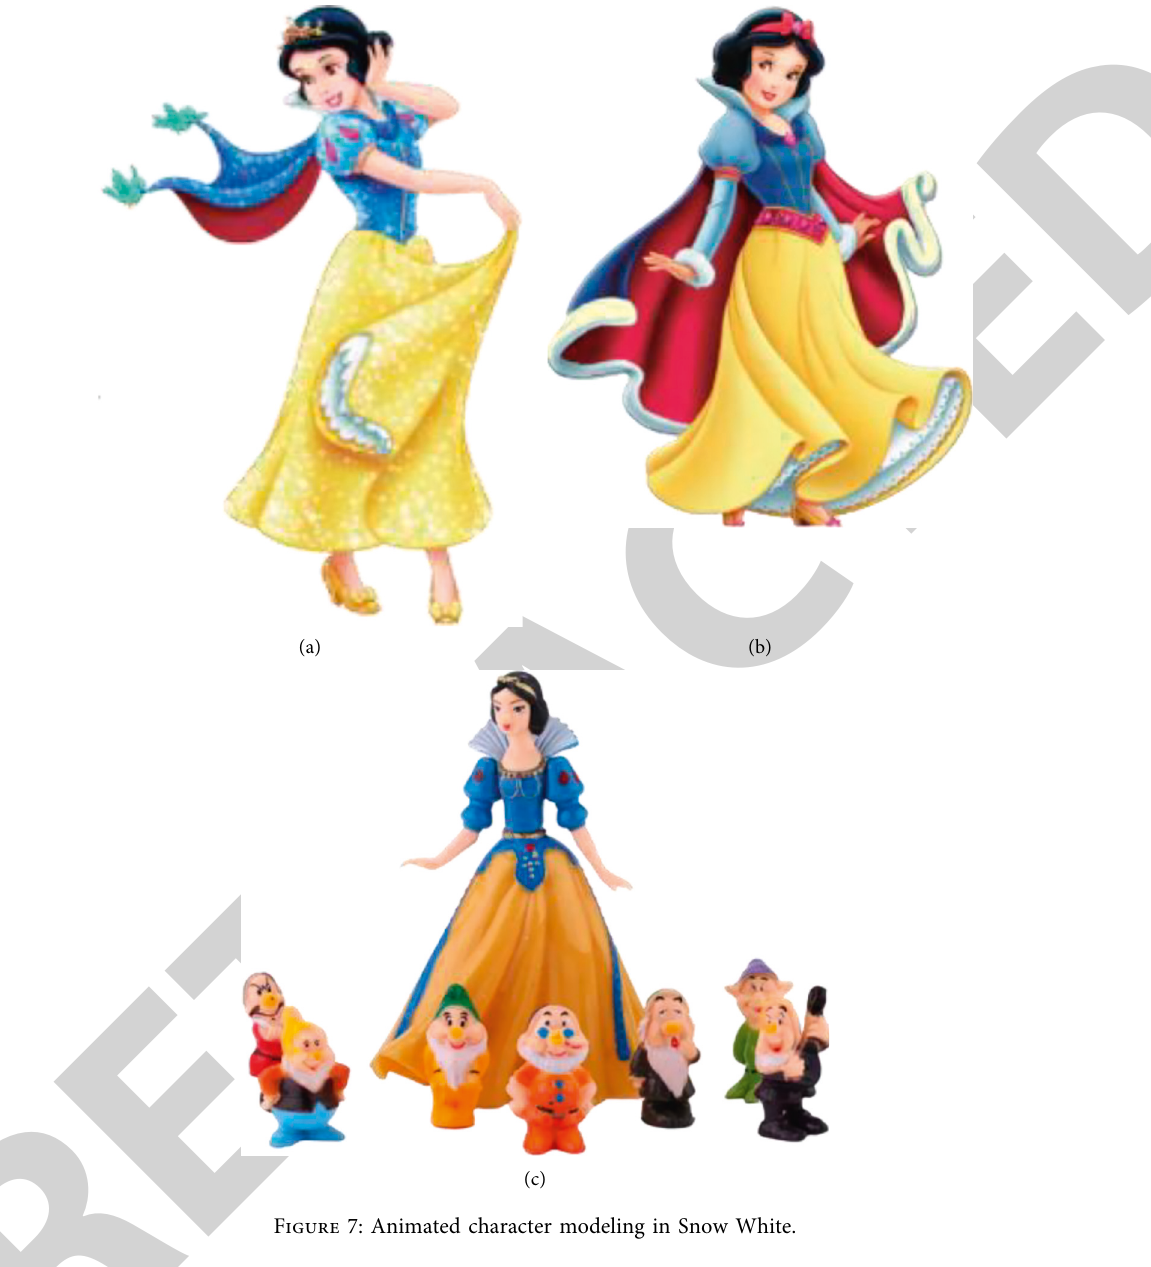
Figure 7: Animated character modeling in Snow